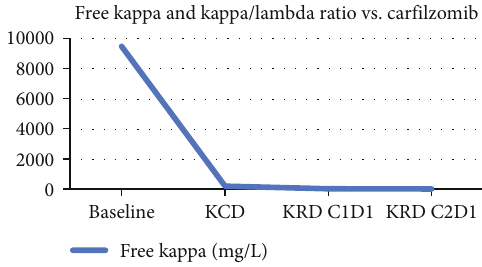
Figure 2: Multiple myeloma marker responses to car fi lzomib. Demonstration of cycle-dependent decline in free kappa and kappa/lambda